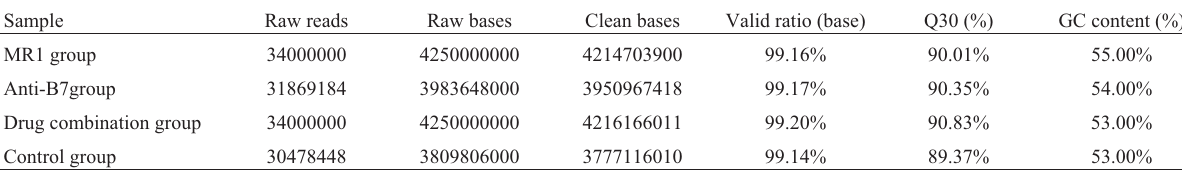
Q30: percentage of bases with Phred values greater than 30 of total base number. General requirements are of less than 85%.